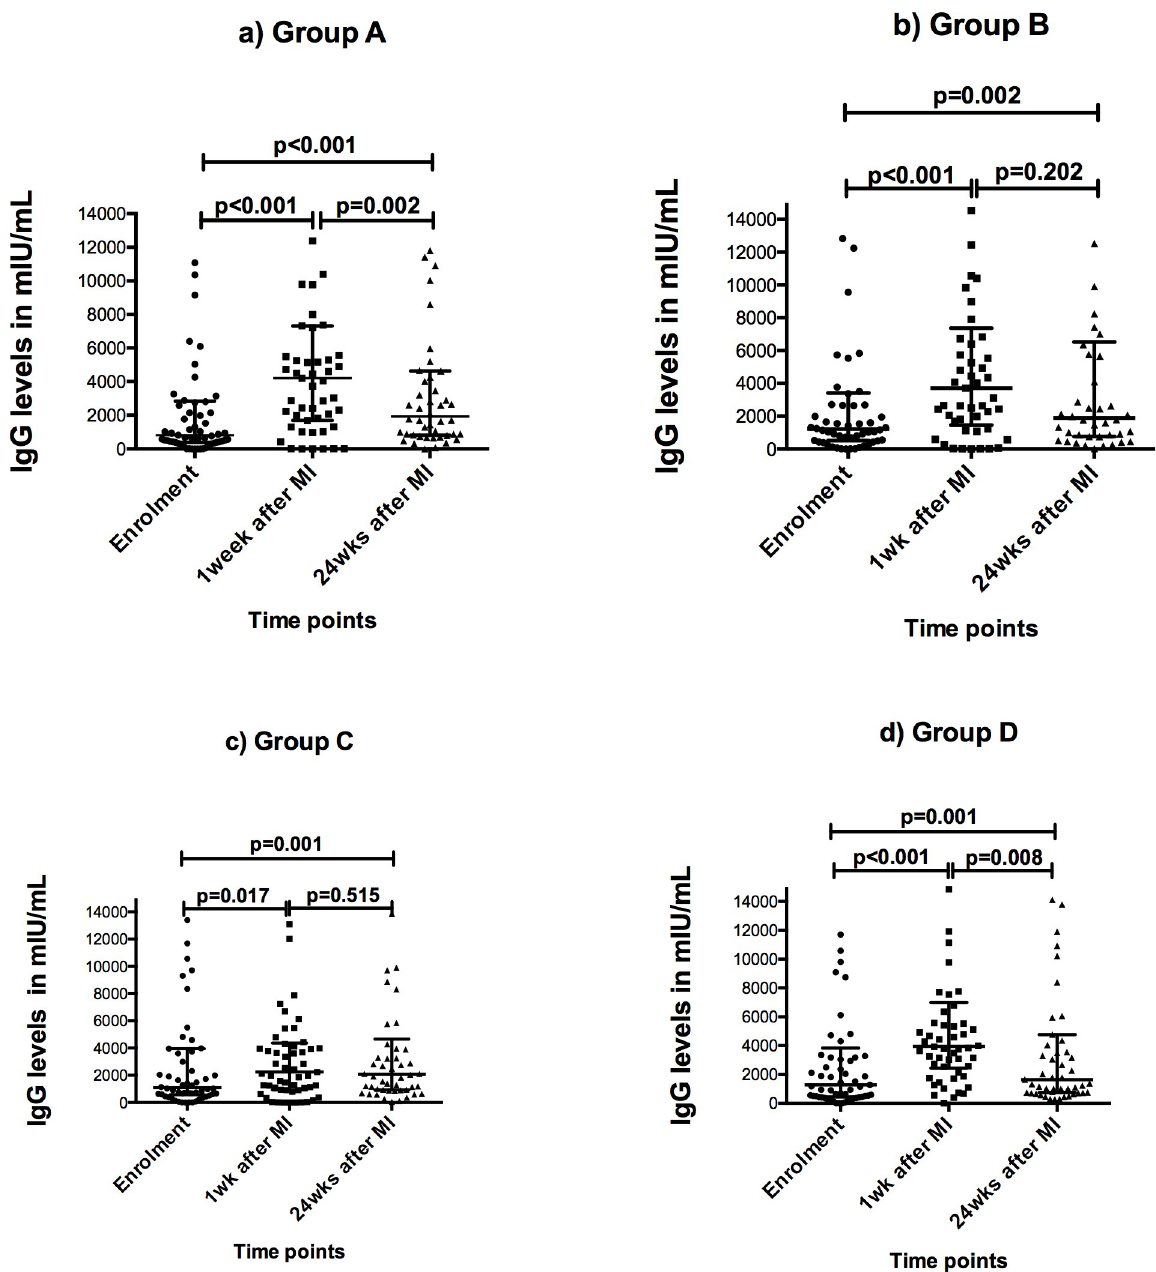
Fig 2. Anti-measles IgG levels at respective time points for each treatment group. Group A received praziquantel (PZQ) 2 weeks before measles immunization (MI), Group B received PZQ at the time of MI, Group C received PZQ one week after MI and Group D was S mansoni negative and did not receive PZQ. Shown on the dot plots are medians with inter-quartile whiskers and the Wilcoxon Signed-rank paired sample test